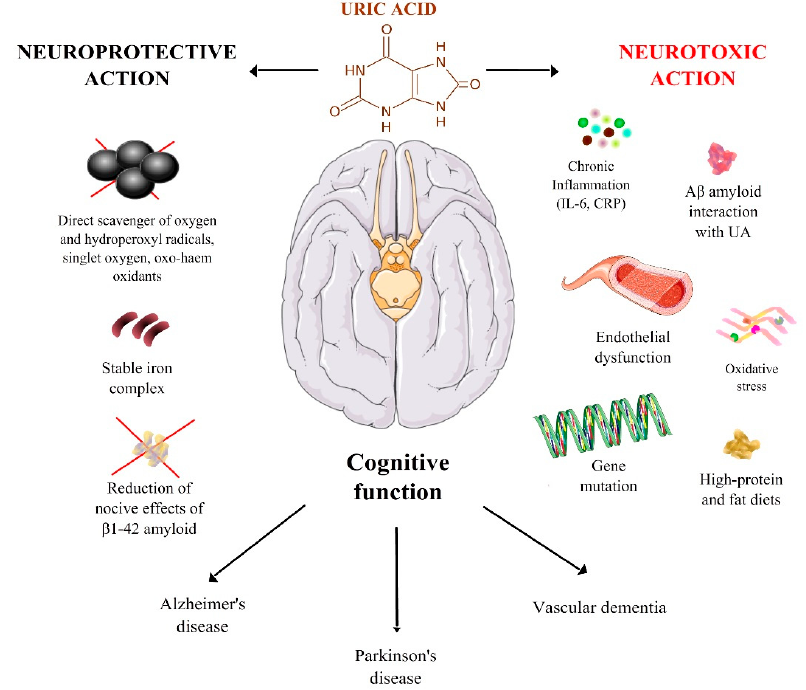
Figure 1. Summary of the main mechanisms of interaction between uric acid and cognition in the physio-pathology of different types of dementia. The specific mechanisms are discussed in the